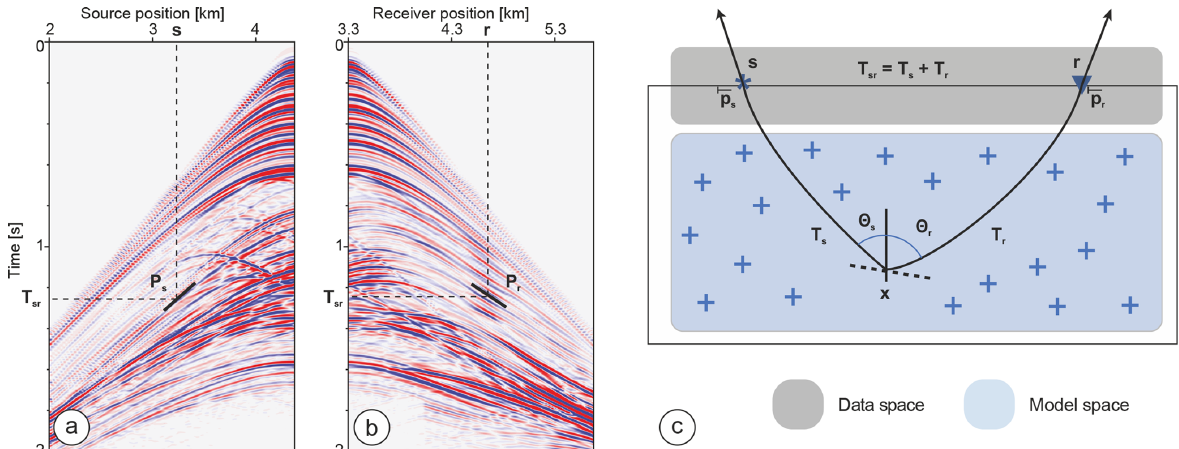
Figure 6. Local coherent events picked for ST. Each local coherent event is described by the source and receiver positions (s, r), the slopes ( P s , P r ) picked in (a) common-shot and (b) common-receiver gathers, and two-way travel time T sr . (c) Data space and model space in ST. The symbols ( + ) denote the velocity nodes. Two rays are shot toward the source s and receiver r from the scatterer x with takeoff angles (cid:50) s and (cid:50) r corresponding to one-way travel times T s and T r . The velocity model, the scatterer coordinates x and the ray attributes ( (cid:50) s , (cid:50) r , T s and T r ) form the model space of classical ST. The scatterer position x and the two takeoff angles ( (cid:50) s , (cid:50) r ) define a dip (migration facet). The horizontal component of the slowness vectors at the source and receiver positions, P s and P r , the two-way travel time T sr , and the source and receiver positions (s, r) form the data space of classical ST (adapted from Tavakoli et al.,